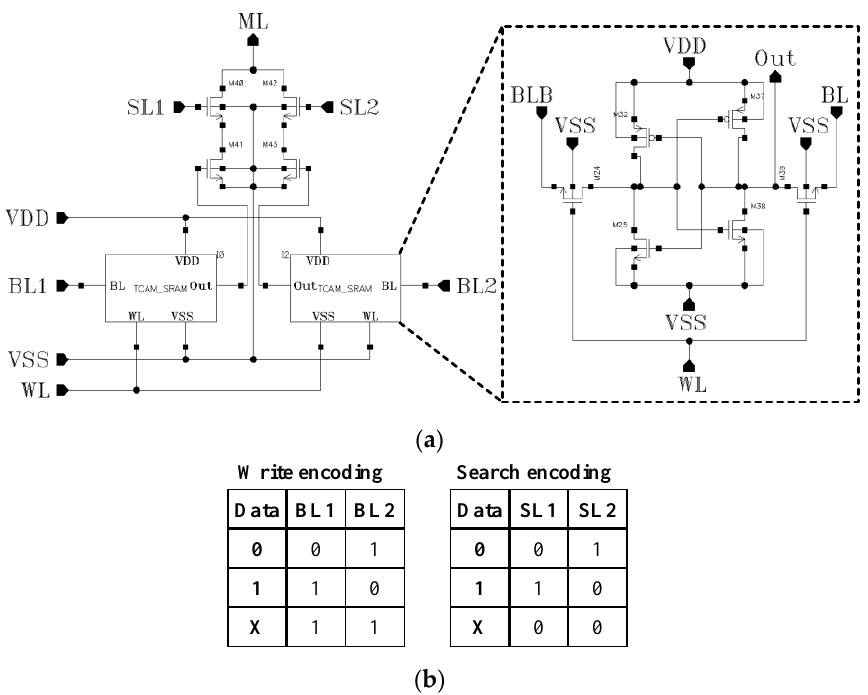
Figure 6. Schematic design of ( a ) CMOS-based TCAM cell; and ( b ) data encodings for write and search [7].